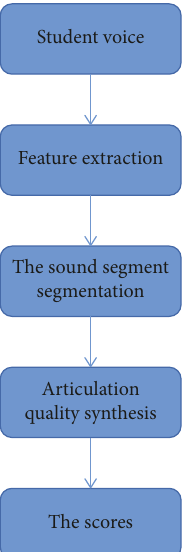
Figure 2: Basic framework of speech evaluation.